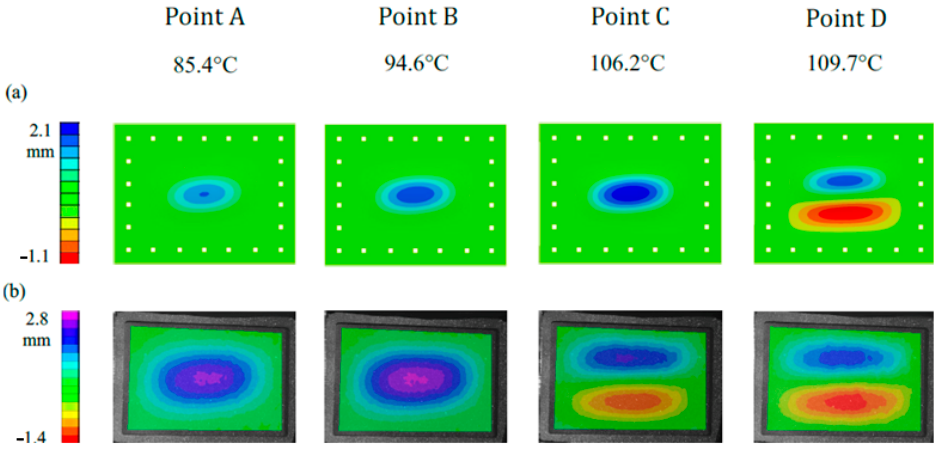
Figure 15. Out-of-plane deformation for [30/−30/5/−5] (cid:3046) composite plate: ( a ) FE analysis; ( b ) Test.